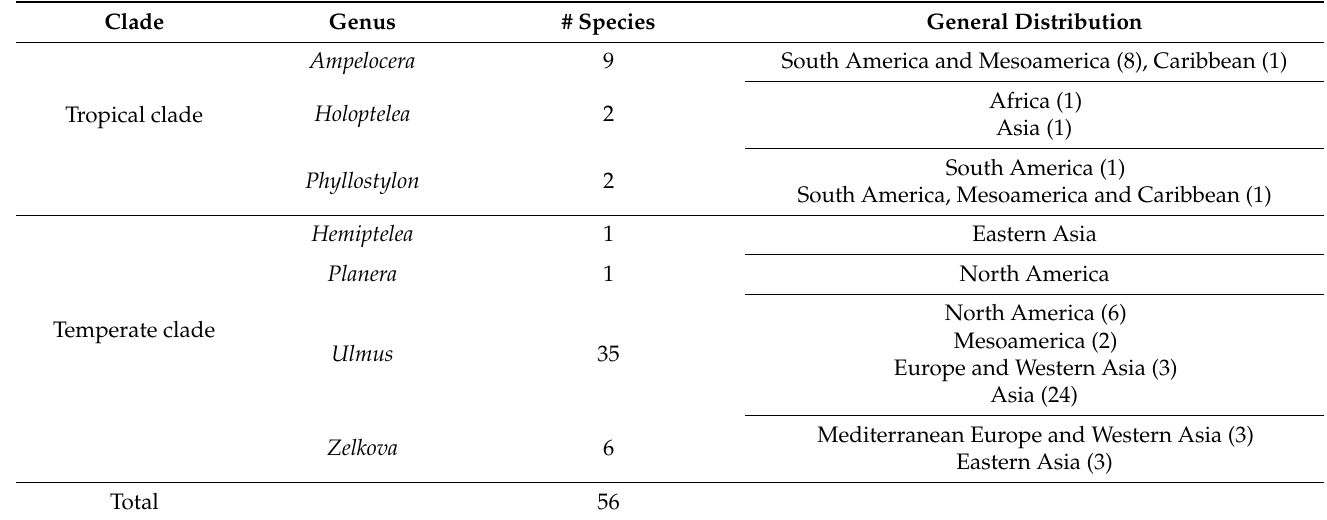
Table 1. Summary of the taxonomic division, genera and species number, and general distribution of the elm family (Ulmaceae). # Species: number of species. Parenthesis: number of species by region. Clade Genus # Species General Distribution Ampelocera Tropical clade